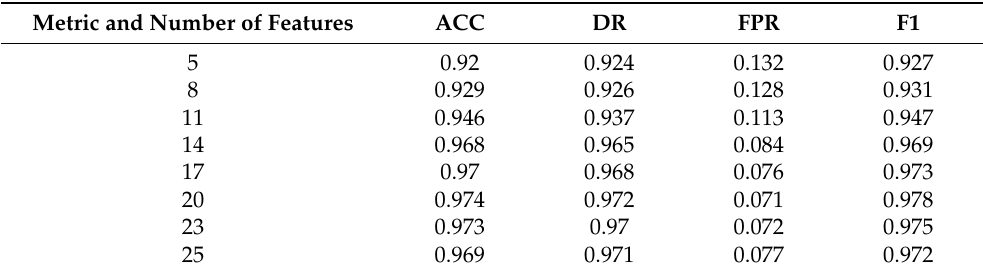
Table 1. The experimental evaluation results for the proposed ADBN-IDS in terms of accuracy, detection rate, false positive rate, and F measure.